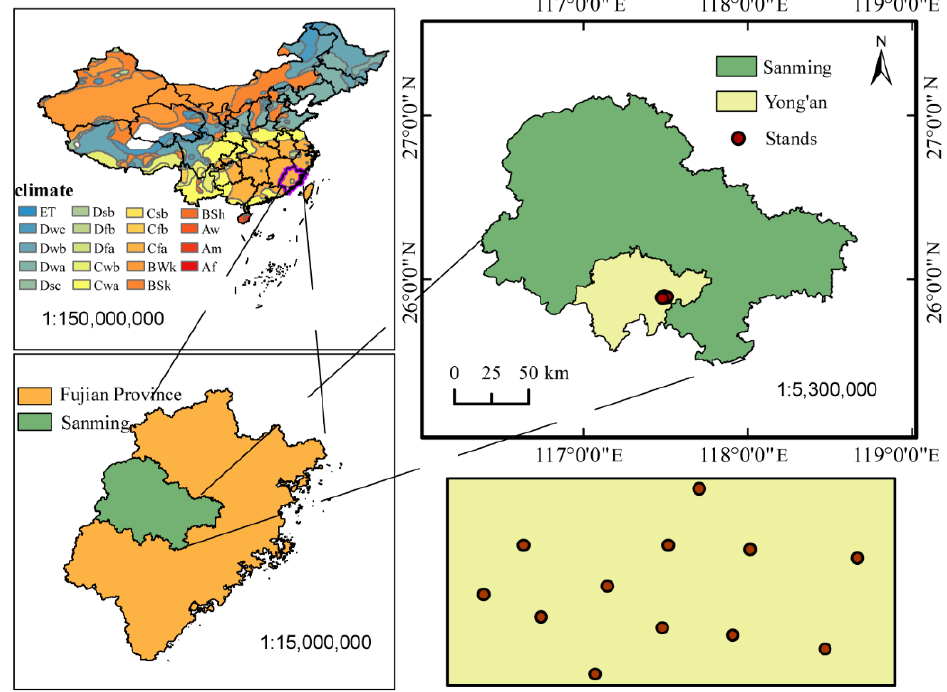
Figure 1. The geographic location of the study site.